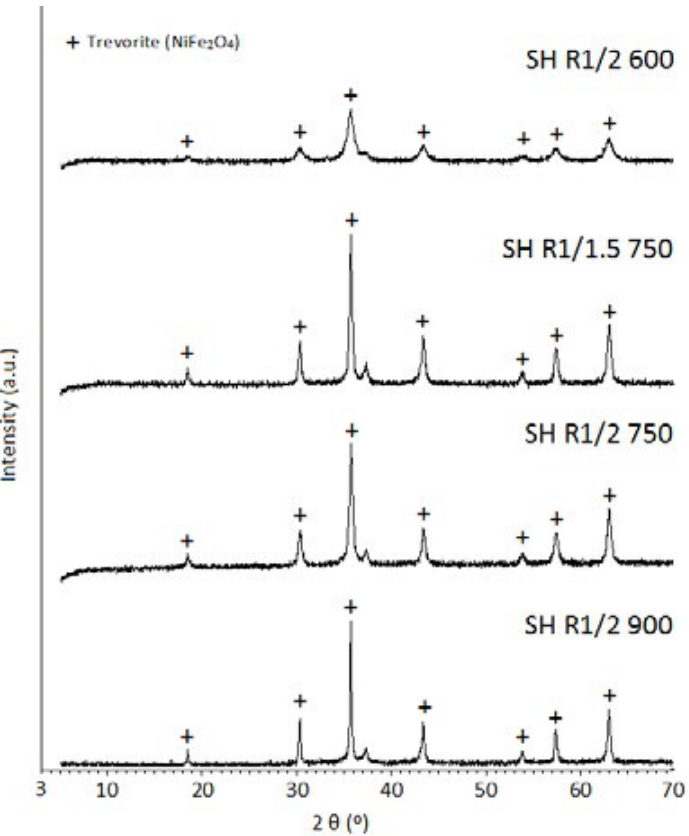
Fig. 4: XRD pattern of ferrites prepared by the co-precipitation pathway